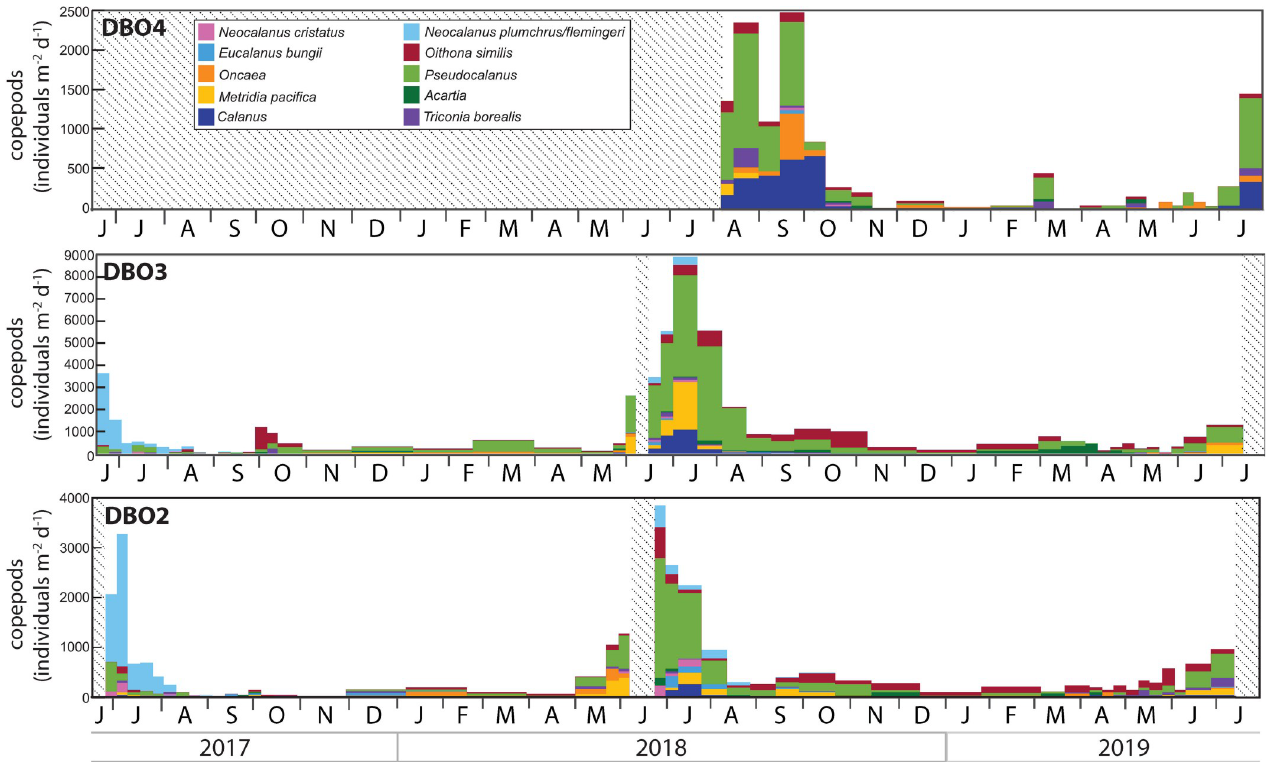
Fig 6. Dominant copepod groups collected in the sediment trap at each mooring site. Note the different scales. Shaded areas represent periods without data.